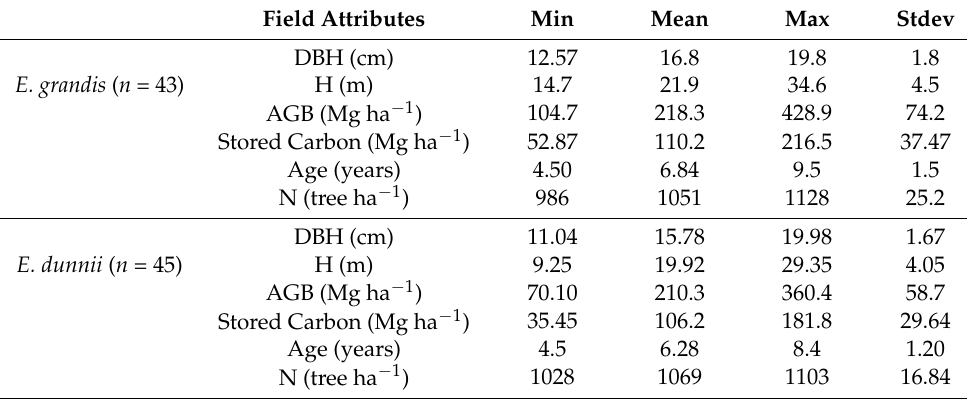
Table 1. Stand characteristics of Eucalyptus grandis and Eucalyptus dunnii in Uruguay. Variables and abbreviations: diameter at breast height (DBH, cm); total height (H, m); above ground biomass (AGB, Mg C ha − 1 ); stored carbon (Mg ha − 1 ); age (years); and stem density (N, trees ha − 1 ). Where: stdev = standard deviation, min = minimum, max =